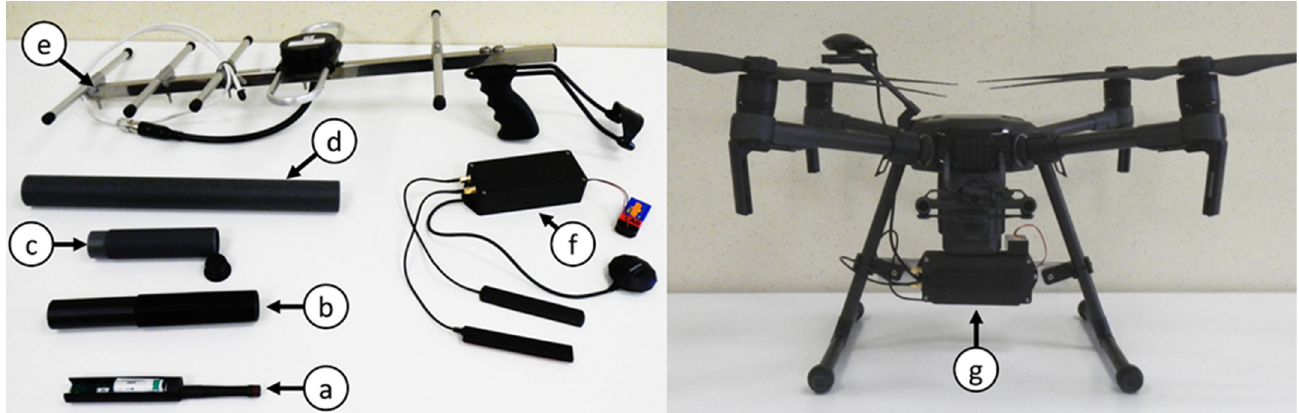
Figure 4. ( a ) Kinematic Logger, battery, and 433 MHz antenna installed in a 3D printed sleeve, ( b ) threaded waterproof housing for the Kinematic Logger, ( c ) threaded end plugs to span the distance between the Kinematic Logger and the surface of the stone, ( d ) threaded sleeve that is glued into the stone, ( e ) directional Yagi antenna with handle and wrist support for Kinematic Logger recovery missions, ( f ) relay unit with antennas and 9 V battery, ( g ) relay unit installed on a DJI M210 UAV.